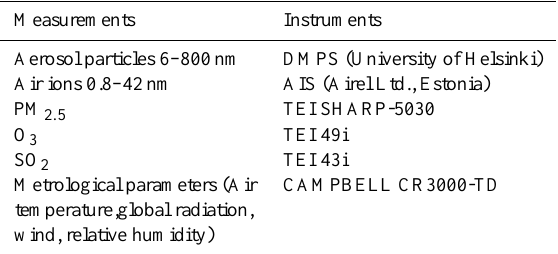
plus 1 min background determination), making for a time res- Table 1. Instruments used in this